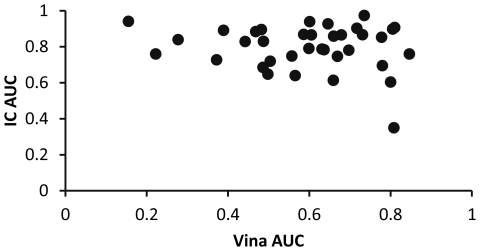
Virtual screening.Results of ROC-AUC analysis for 39 DUD protein virtual screening analyses are shown. AUC values obtained by the internal consensus method are compared to those from Vina scoring. Values above 0.5 indicate successful selection of ligands over decoys. The differences between Vina and the internal consensus method are significant (two-tailed, paired T-test; p<2.0×10−7).